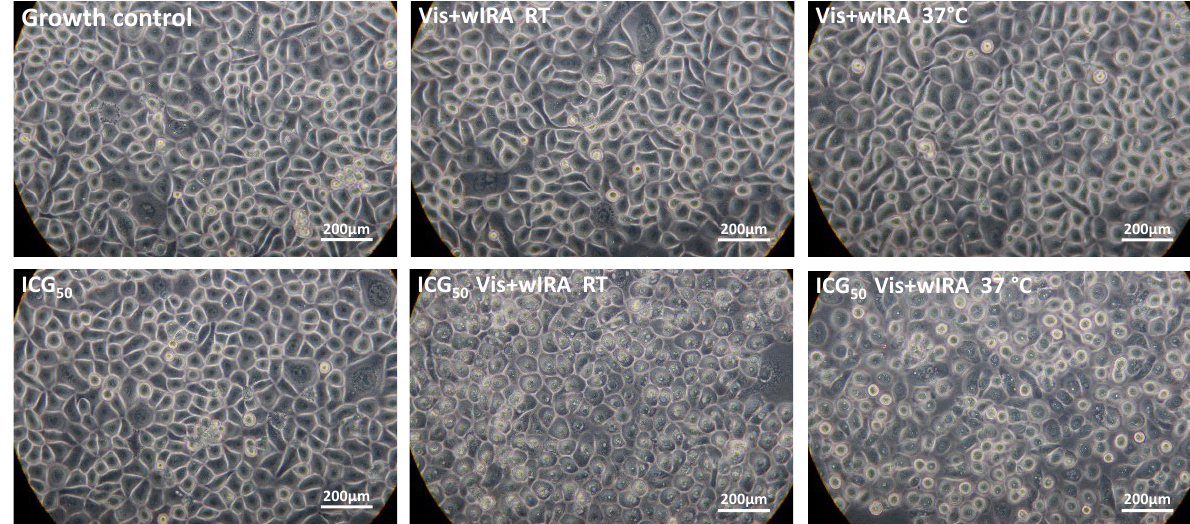
Figure 6. After only 5 min of treatment, 50 g/mL ICG and Vis + wIRA lead to morphological damage in cells. Human gingival keratinocytes were incubated with 50 µg/mL ICG and irradiated with Vis + wIRA at RT or at 37 °C in a water bath. All experimental approaches were washed twice after treatment with PBS buffer and microscopically examined at a magnification of 400×. The scale bar is shown on the bottom right. Additional light microscope images of the other ICG concentrations and time points are attached in the supplement.